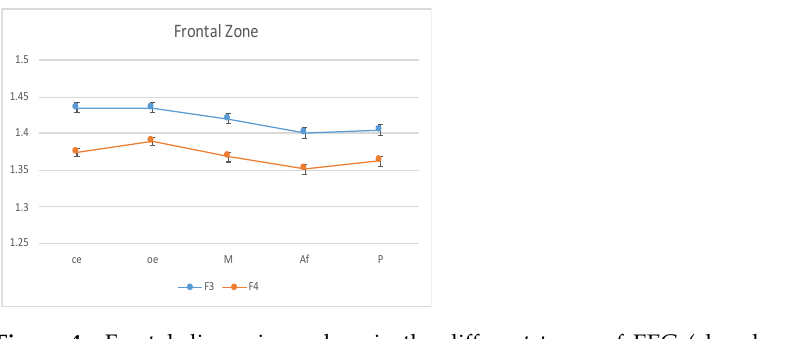
Figure 4. Fractal dimension values in the different types of EEG (closed eyes (ce), open (oe), Afghanistan-type driving (Af), Mali-type driving (M), and training track (P)) in the frontal area (F3, F4).